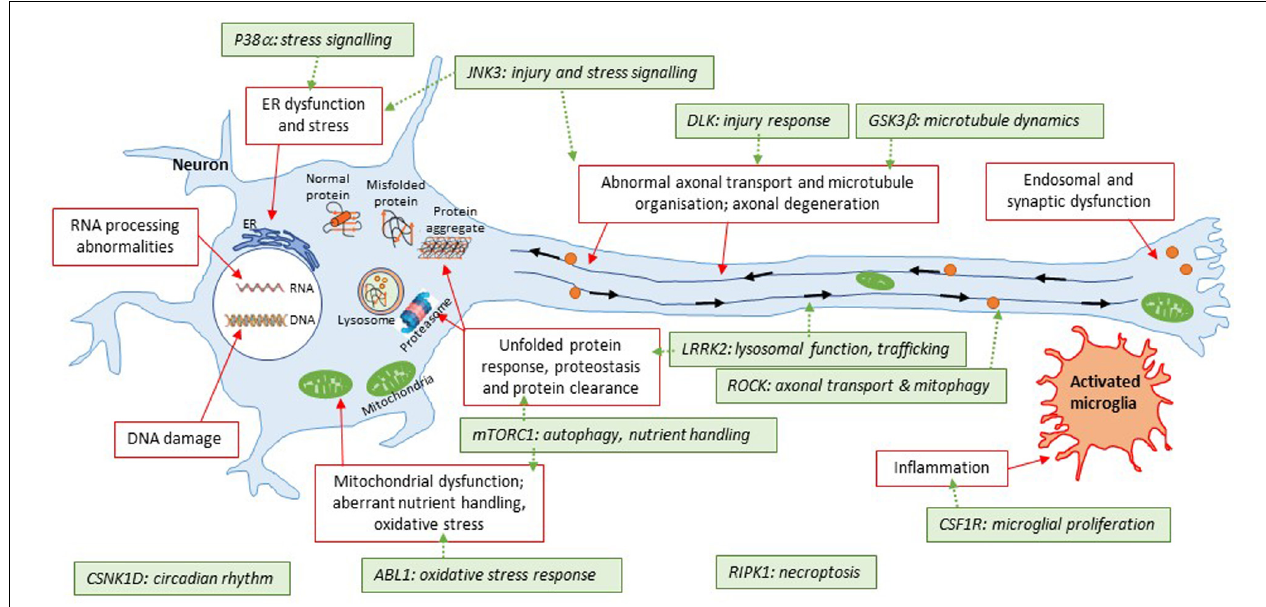
FIGURE 3 | Illustration of kinase targets covered in this review with respect to converging pathways in neurodegeneration. This simplified schematic summarizes some of the common areas of pathophysiology in neurodegenerative diseases. The general theme is that the disease protein(s) are misfolded; which then triggers a number of downstream events such as protein aggregation, energy imbalances, altered proteostasis, stress responses to the unfolded proteins themselves or downstream consequences of events triggered by the unfolded proteins. Some of these pathways are further connected (e.g., diseased mitochondria can be removed by a specialized form of autophagy, known as mitophagy; furthermore, trafficking defects can apply to specific organelles illustrated here such as autolysosomes). The 11 kinases covered in this review have roles to play with respect to some of these pathways that have been shown to be altered. A key question for many targets is how closely related they are to initial triggers of pathophysiology; and whether inhibition of these targets will beneficially impact on multiple aspects of disease pathophysiology. LRRK2 is an exception here given that it is a bona fide genetic cause of Parkinson’s disease for a subset of